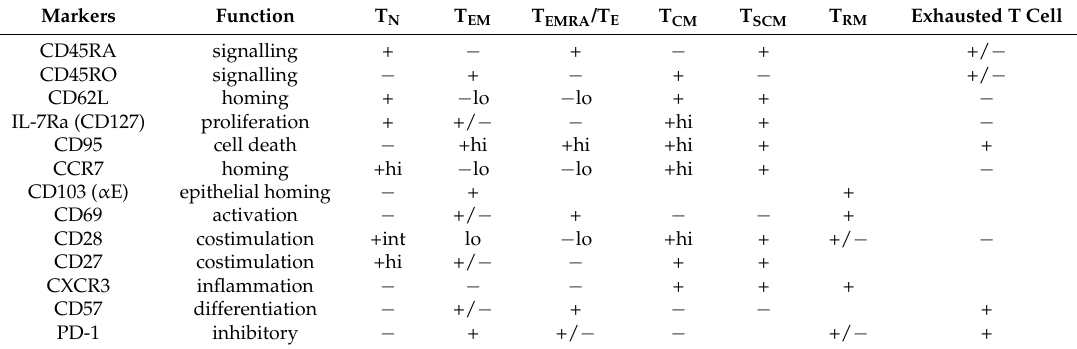
Table 2. Memory T cells (canonical markers, not exhaustive or mutually